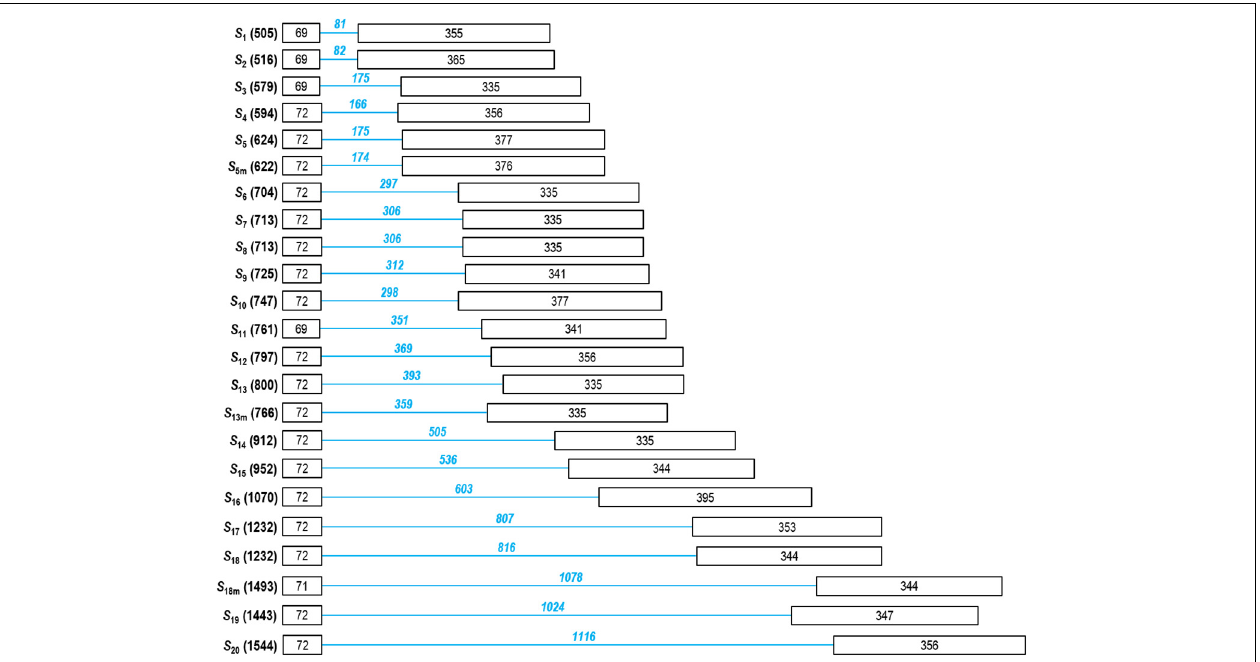
FIGURE 2 | Structure of the partial Prunus laurocerasus putative S-RNase alleles. Boxes and lines represent exons and introns, respectively (not to scale). The DNA sequence was determined between the C2 and C5 conserved regions, and the lengths of exon 2 and 3 (numbers in black) as well as the second intron (numbers in blue) are